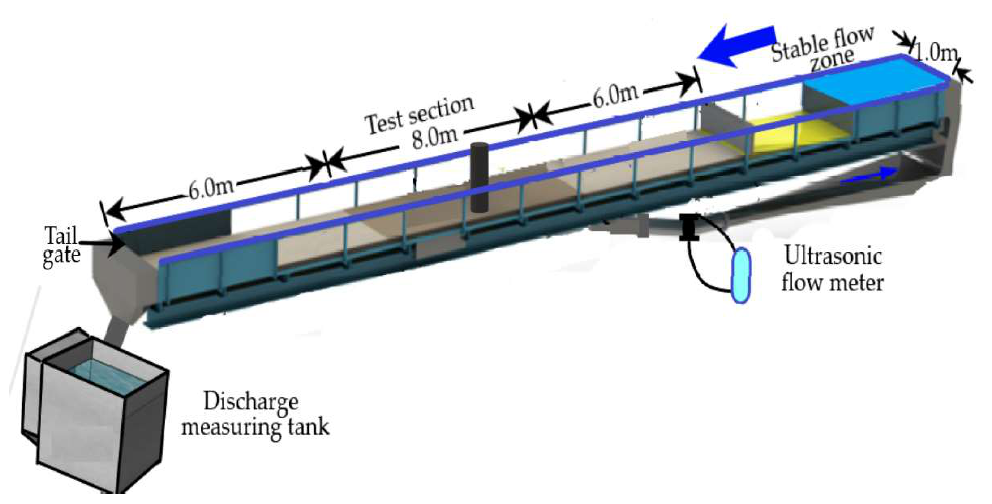
Figure 1. Schematic view of the experimental setup. Table 1. Experimental data of non-uniform gravel bed. Experimental Conditions